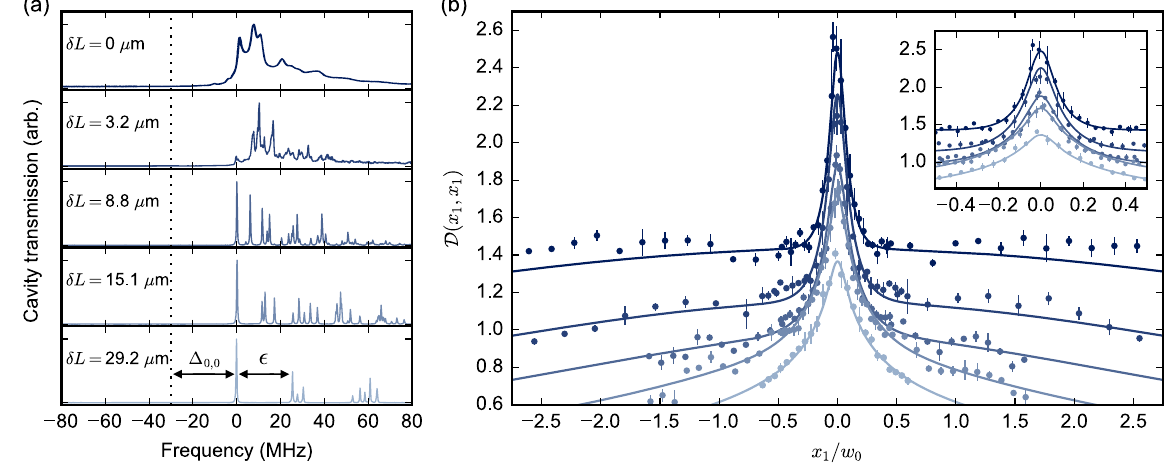
FIG. 2. Dimensionless interaction strengths D ð x 1 ; x 1 Þ versus position of a single BEC for various cavity lengths L . (a) Transmission spectra of the five cavities studied. The spacing between even-mode families is ϵ ≈ 25 MHz for δ L ¼ 29 . 2 μ m. Individual transverse ¼ 30 MHz between modes are unresolvable at confocality ( δ L ¼ 0 μ m). The dotted vertical line indicates the frequency difference Δ 0 ; 0 mode. Images of the superradiant emission are shown in Fig. 4. (b) The spatial dependence of the the pump beam and the TEM 0 ; 0 ¼ 30 MHz. The color of each trace corresponds to the cavity lengths dimensionless interaction energy D ð x 1 ; x 1 Þ , also with Δ 0 ; 0 presented in panel (a). The error bars represent one standard error in the mean over three runs. The solid lines are fits of Eq. (9) to our data and neglect the effect of astigmatism and spherical aberrations on our cavity spectrum. A close-up of data near the cavity center is displayed in the